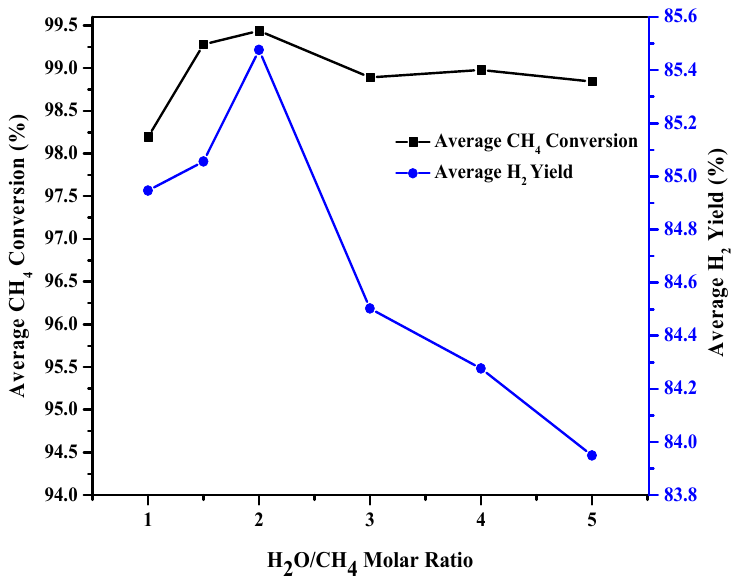
Figure 8. Average methane conversion and hydrogen yield of 20Ni-2.5Y/SBA-16 oxygen carrier at 650 °C for different H 2 O/CH 4 molar ratio.